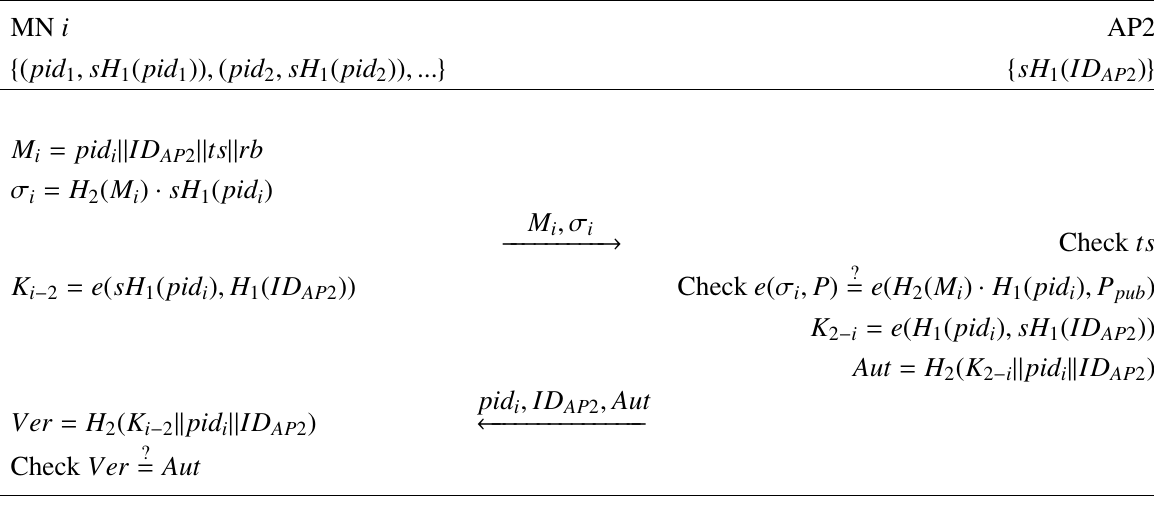
Figure 1. The handover authentication phase in He et al. ’s improved PairHand